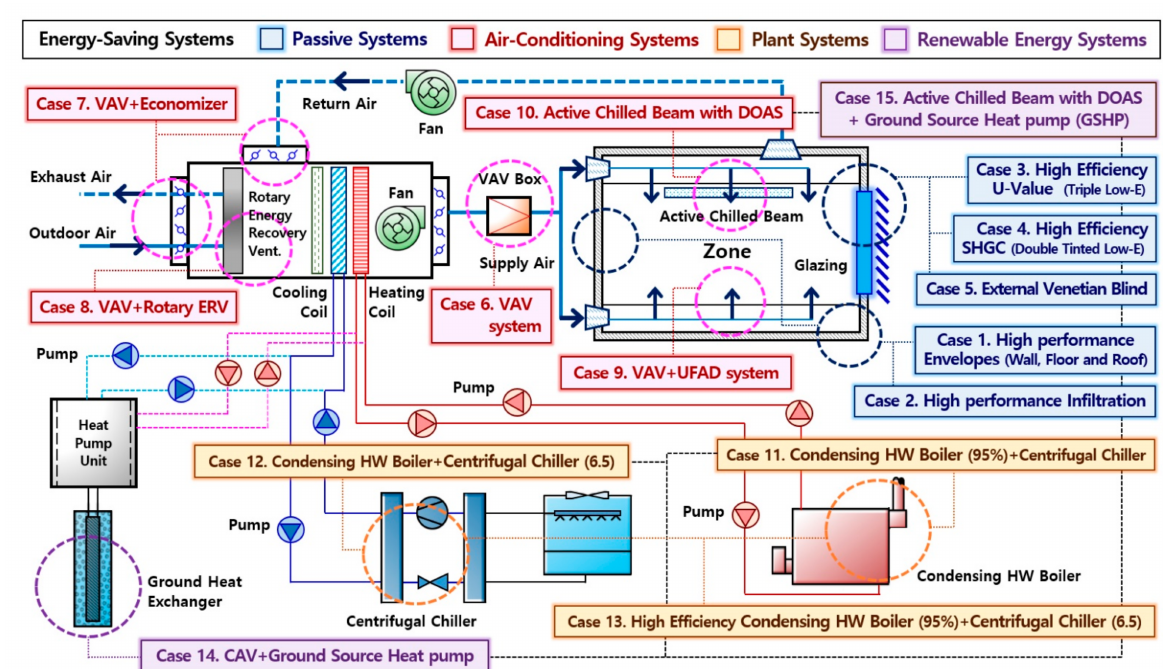
Figure 4. Simplified diagram of energy saving